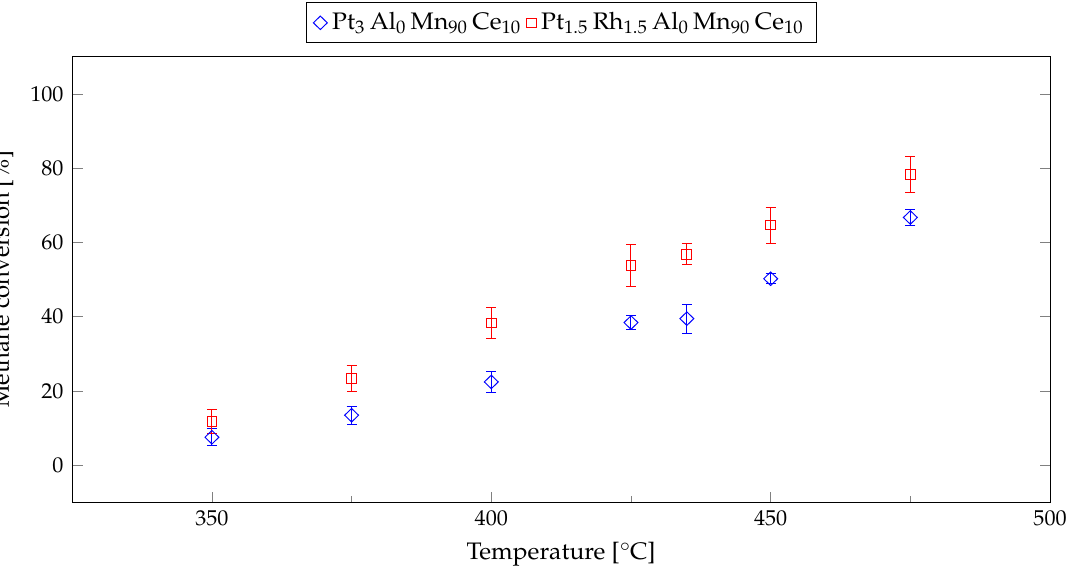
Figure 16. Methane conversion at different temperatures of samples containing Pt 3 or Pt 1.5 Rh 1.5 with a composition in the area around Al 0 Mn 90 Ce 10 . 12.5vol.% H 2 O, 12.5vol.% CO 2 , 9.0vol.% O 2 , 0.25vol.% CH 4 , 0.055vol.% CO, 0.012vol.% NO, 0.004vol.% NO 2 , 0.001vol.% SO 2 , balance He, WHSV = 36000ml/ ( gh ) . Error bars represent standard deviation ( n = 3) as given by Equation 2.